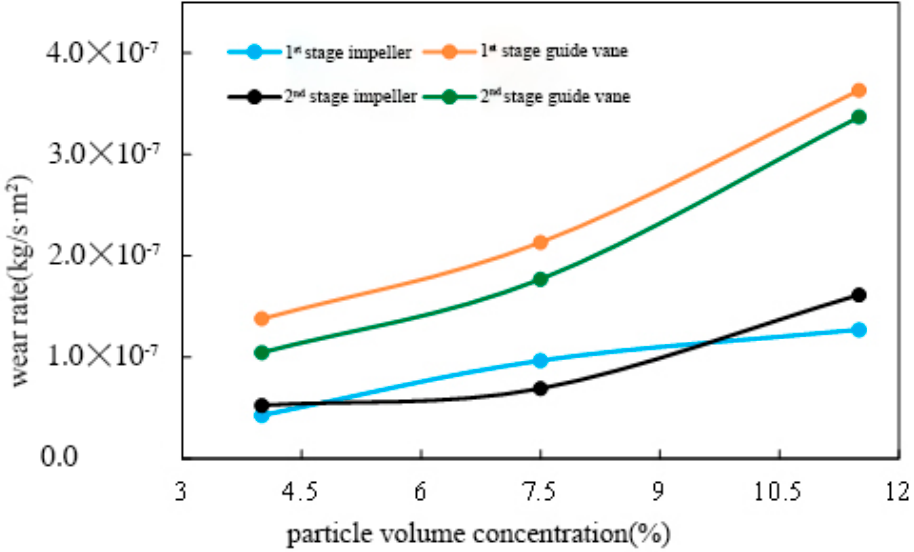
Figure 13. Changes in wear rate on the surface of through-passage components.